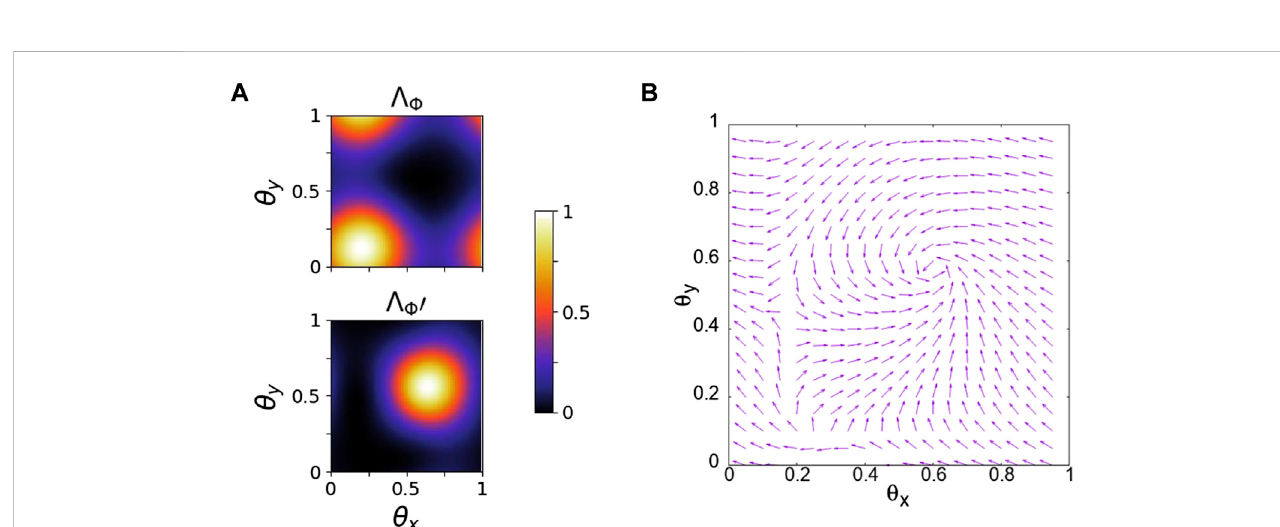
FIGURE 4 Plot of (A) reference gauge fi elds Λ Φ , Λ Φ ′ , and (B) argument fi eld Ω as a function of the twist angles. In the region, where Λ Φ ′ ≠ 0 and Λ Φ = 0, we see a vortex in the Ω fi eld with a phase accumulation of 2 π around it. Similarly, in the complementary region, we see an anti-vortex in the Ω fi eld. Thus, there is only single-branch vortex in each region, which signi fi es that the many-body Chern number is equal to 1.